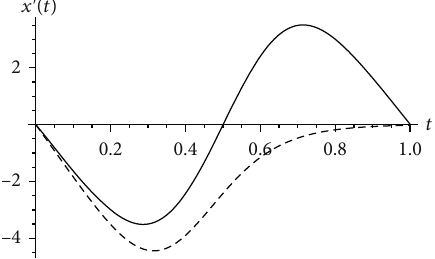
Figure 5: Graphs x ′ ð t Þ for solutions of problems (15) and (30), x α ≈ 0 : 352 , x α ≈ 0 : 40228